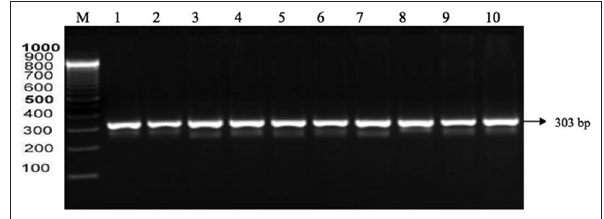
Figure-3: Polymerase chain reaction electrophoresis results with primary Madrasin cattle follicle-stimulating hormone receptor genes suffering from hypofunction. Lane M: Marker, lanes 1-10 show the results of the electrophoresis of Madura cattle rFSH gene with a length of 303 bp.